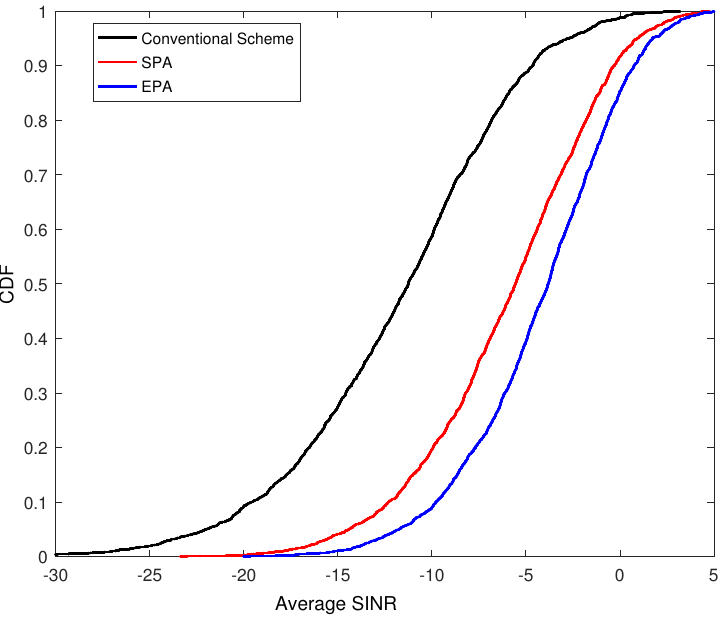
Figure 7. The CDF of the average SINR when M = 64 using MRC.